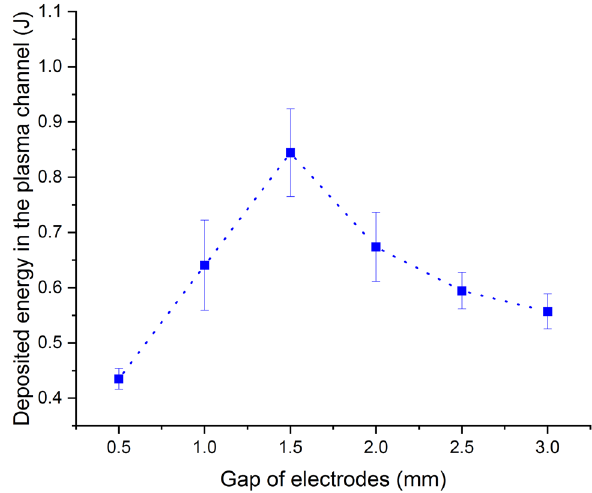
Figure 6. The deposited electrical energy versus